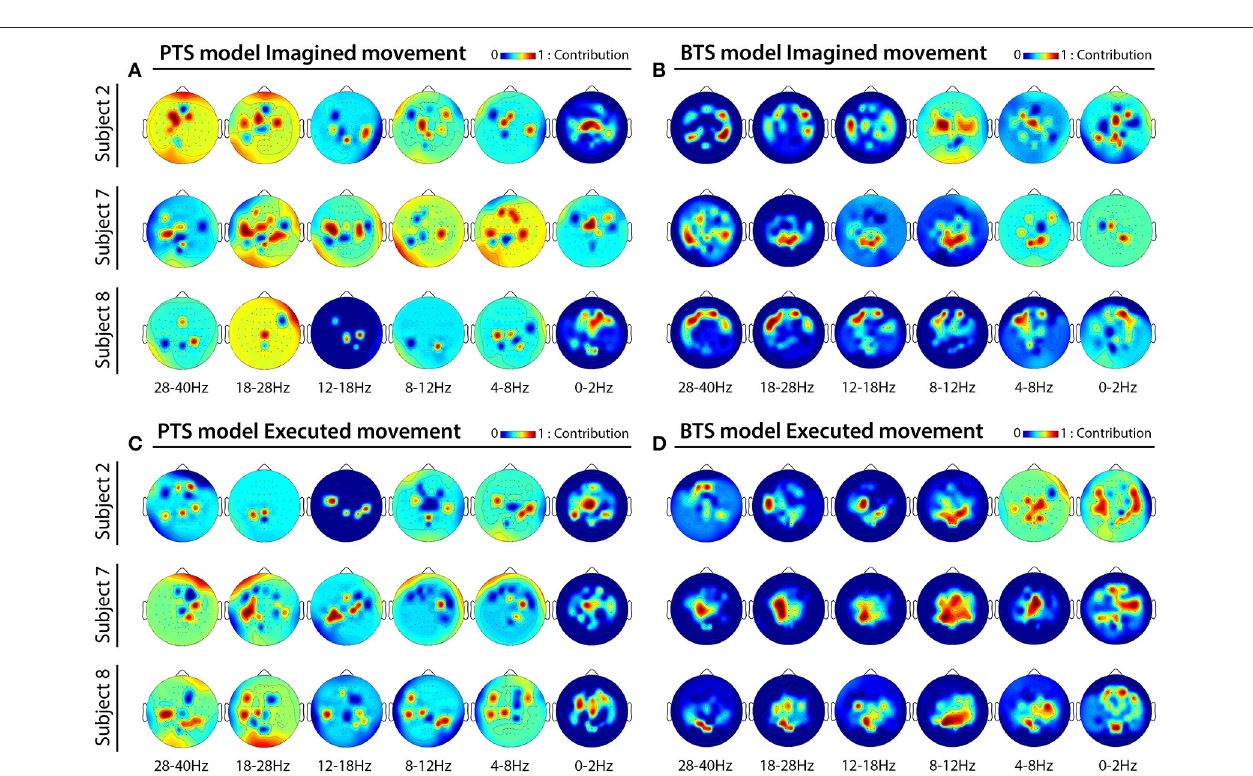
FIGURE 8 | Subject specific topographical maps. Topographical distribution of electrode contribution to the reconstruction of imagined and executed arm movements for subjects 2, 7, and 8 [i.e., subjects for whom reconstruction accuracy was highest (see Figure 6 )]. Color coding—contribution of significant channels [ p < 0.05, Student two-tailed t -test corrected for FDR (false discovery rate)] based on accuracy rates of single channel setups in 6 × 5 inner folds indicating cortical areas providing a high contribution for trajectory decoding. (A,C) Present topographical maps for imagined and executed arm movements using band-pass filtered potentials for the PTS model, respectively. (B,D) Present topographical maps for imagined and executed arm movements using PSD values for the BTS model, respectively.